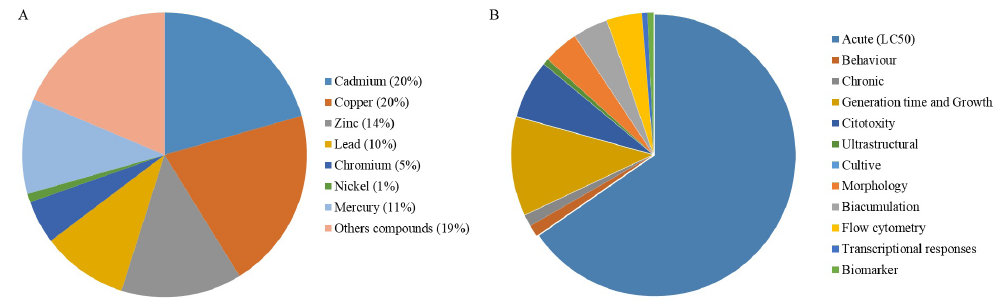
Figure 2. A=Percentage of ecotoxicological studies per compound; B= Endpoints